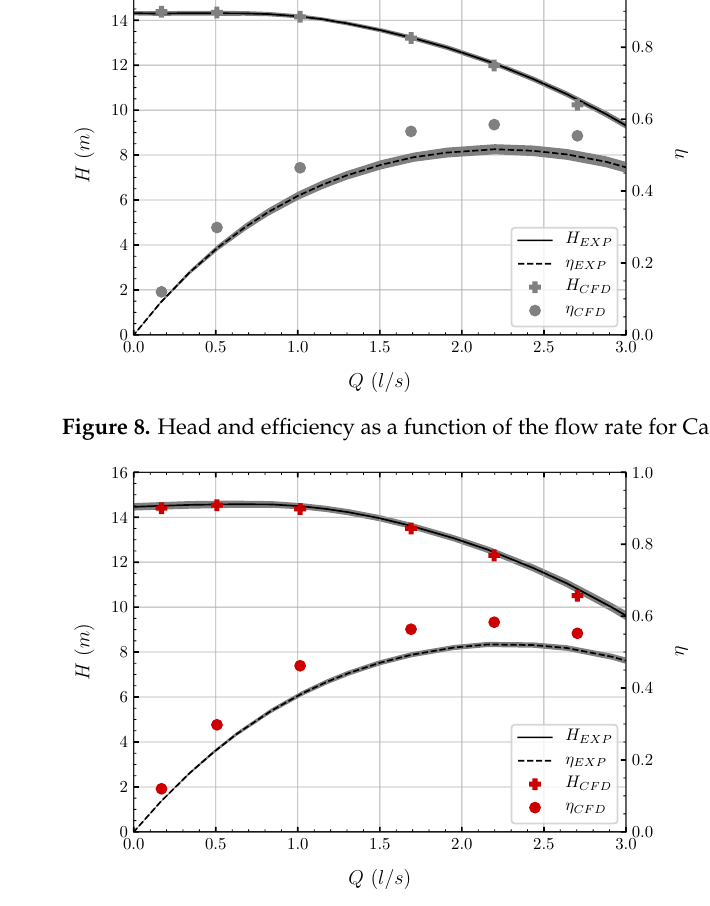
Figure 9. Head and efficiency as a function of the flow rate for Case